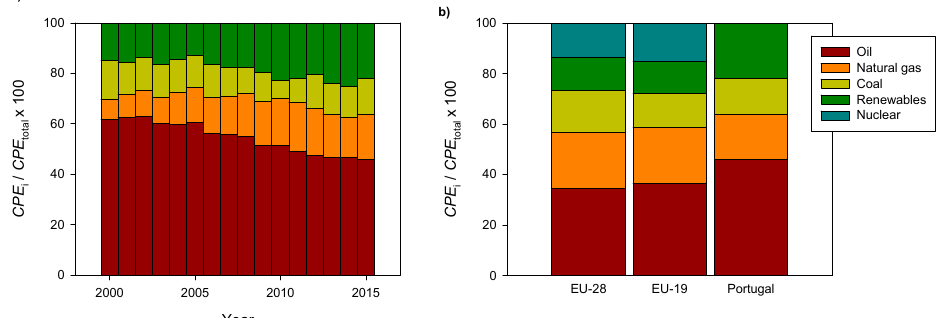
Figure 4. Normalized primary energy consumption per type of source in Portugal: ( a ) From 2000 to 2015 and ( b ) comparison with EU groups in 2015. Authors calculations based on data taken from Eurostat online database [22] and excluding the negligible contribution of non-renewable waste sources.